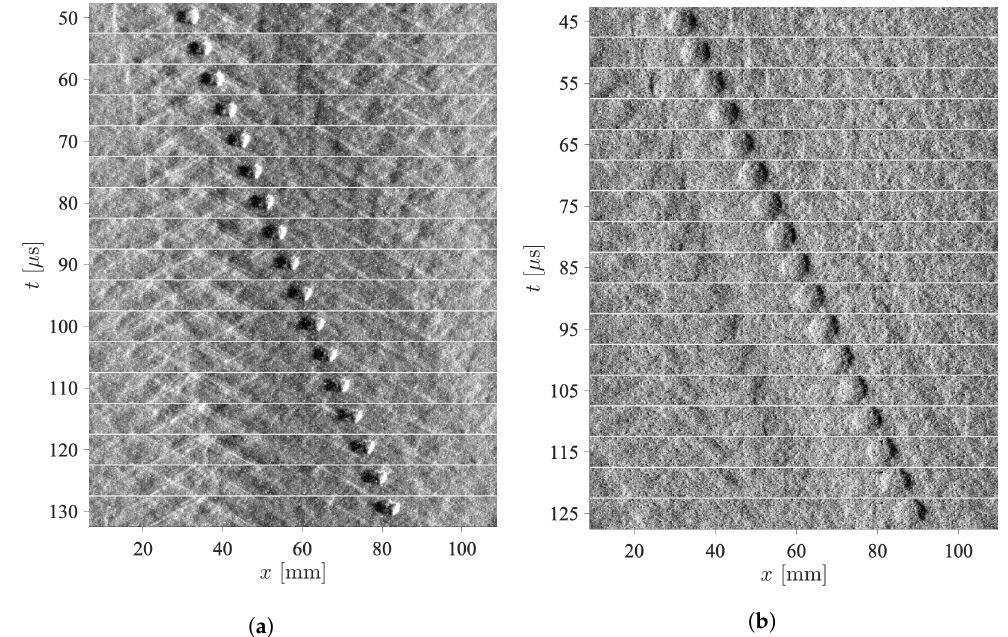
Figure 10. Representative compiled schlieren images of the hot gas kernel. Flow is left to right. ( a ) Mach 2 flow with T 0 = 500 K and P 0 = 2.6 bar. ( b ) Mach 4 flow with T 0 = 350 K and P 0 = 4